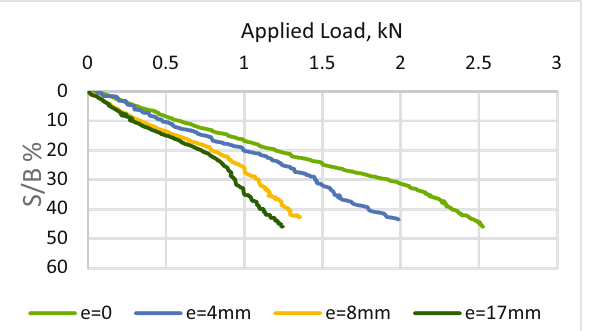
Figure 15: Ultimate bearing load at D s = 1 B .